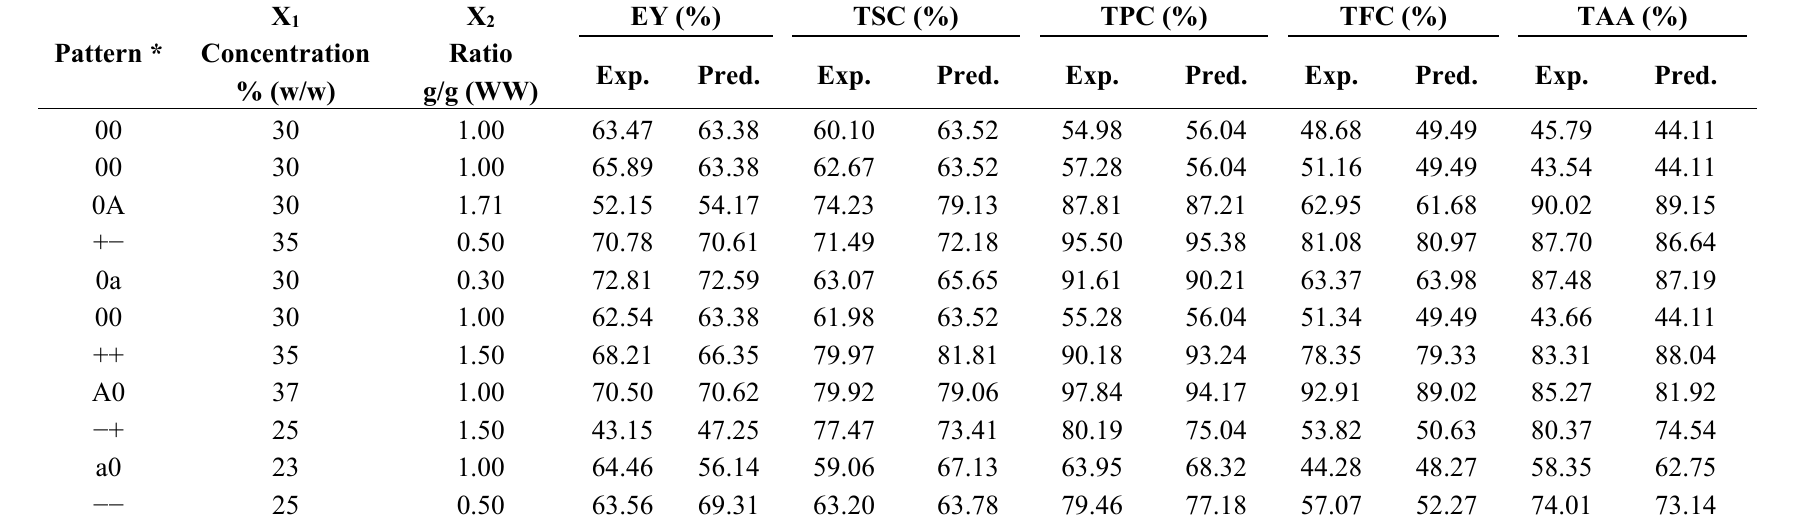
Table 3. The experimental (Exp.) and predicted (Pred.) values for the encapsulation yield (EY) and the retentions of total saponin (TSC), total phenolic (TPC) and total flavonoid (TFC) content and the total antioxidant activity (TAA) for the bitter melon extract encapsulated powder obtained from the RSM CCD